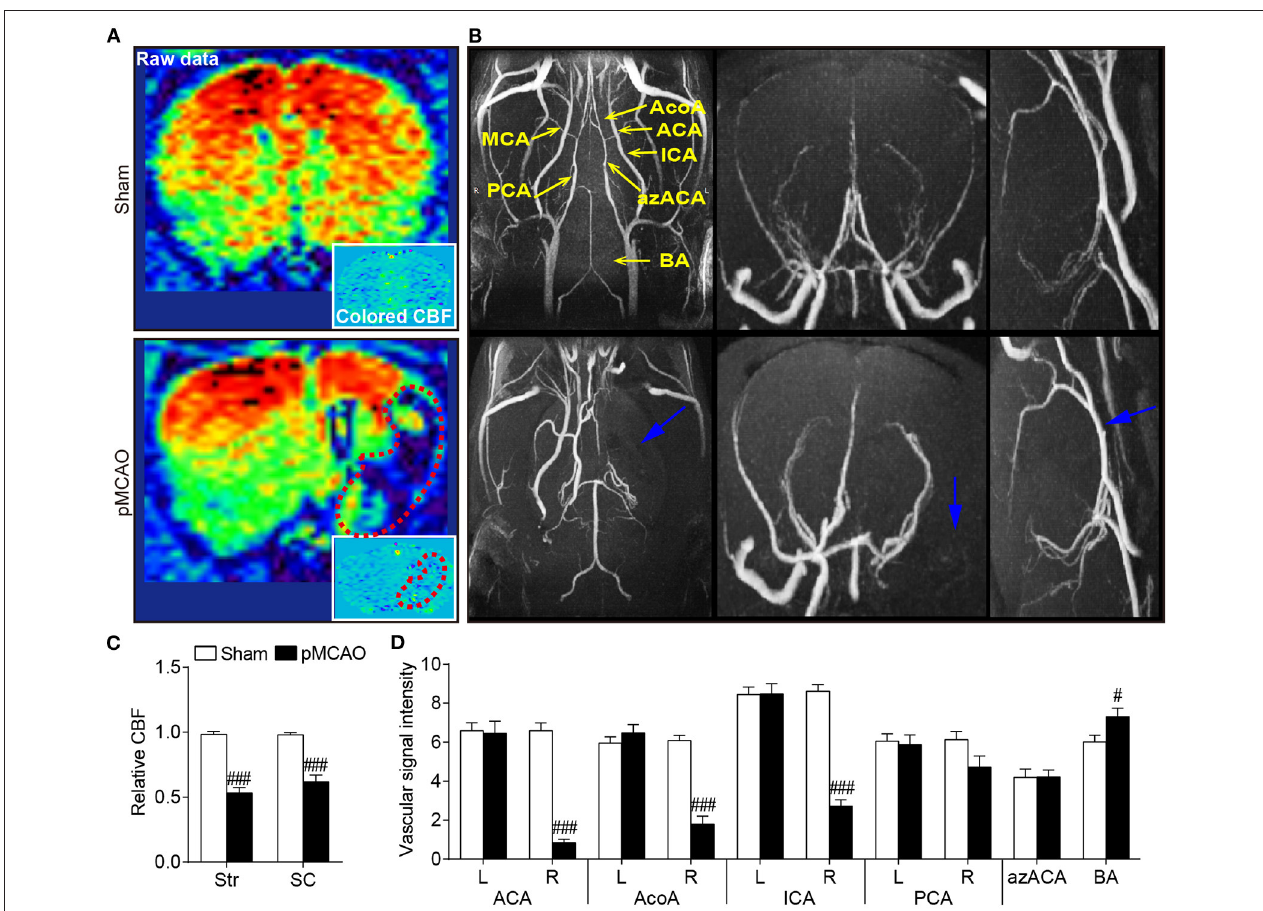
FIGURE 3 | pMCAO resulted in impaired cerebrovascular hemodynamics in rats. (A) Representative coronal raw data and colored CBF maps from the sham and pMCAO rats. (B) Typical axial, coronal, and sagittal MIP images of the sham and pMCAO rats. (C) Quantitative data of relative CBF in the sensorimotor cortex (SC) and striatum (Str). (D) Quantitative analysis of the vascular signal intensity from the bilateral anterior cerebral artery (ACA), anterior communicating cerebral artery (AcoA), internal carotid artery (ICA), posterior cerebral artery (PCA), anterior azygos cerebral artery (azACA), and basilar artery (BA) (Student’s t -test, N = 8 for the sham group and N = 9 for the pMCAO group). # P < 0.05, ### P < 0.001 vs. sham group.